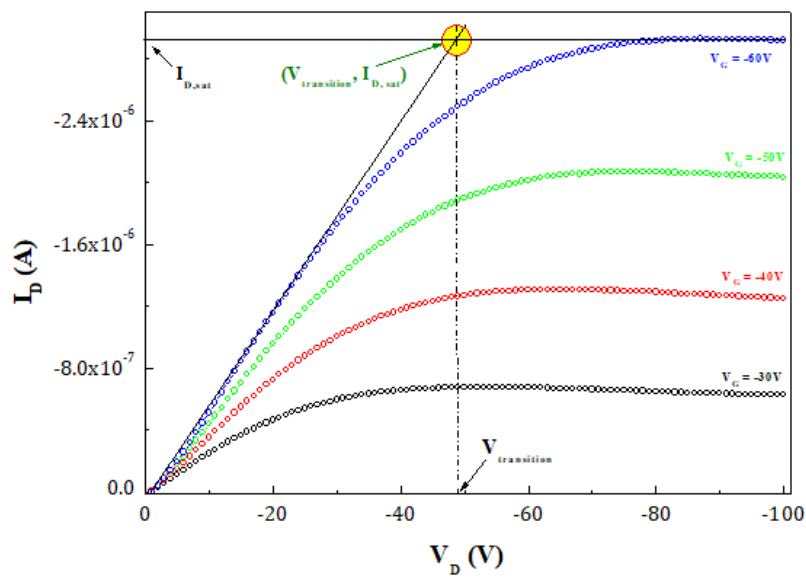
Figure 3. Graphical method extraction of the parameters V transition and I D,sat from the intersection of the two slopes in the linear and saturation regimes of the output characteristics (an example for I D ‐ V D of T 2 (CuPc ‐ TFTs) at high gate voltages).